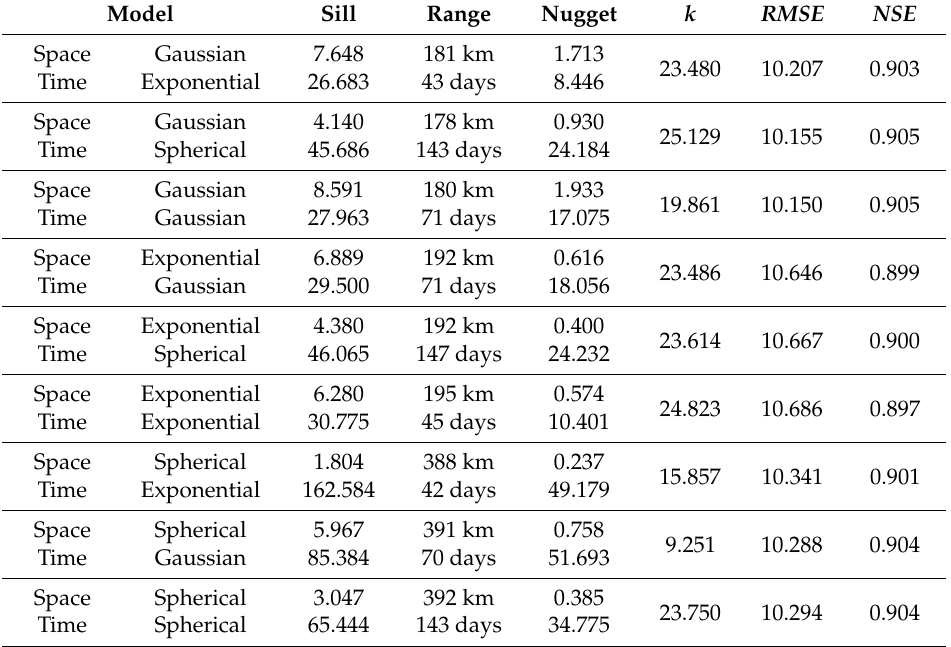
Table 3. Estimations of parameters (sill, range, and nugget) of the generalized product-sum variogram model fitted for the residuals and root mean square error ( RMSE ) and Nash–Sutcli ff e e ffi ciency ( NSE ). The parameter k involves the global